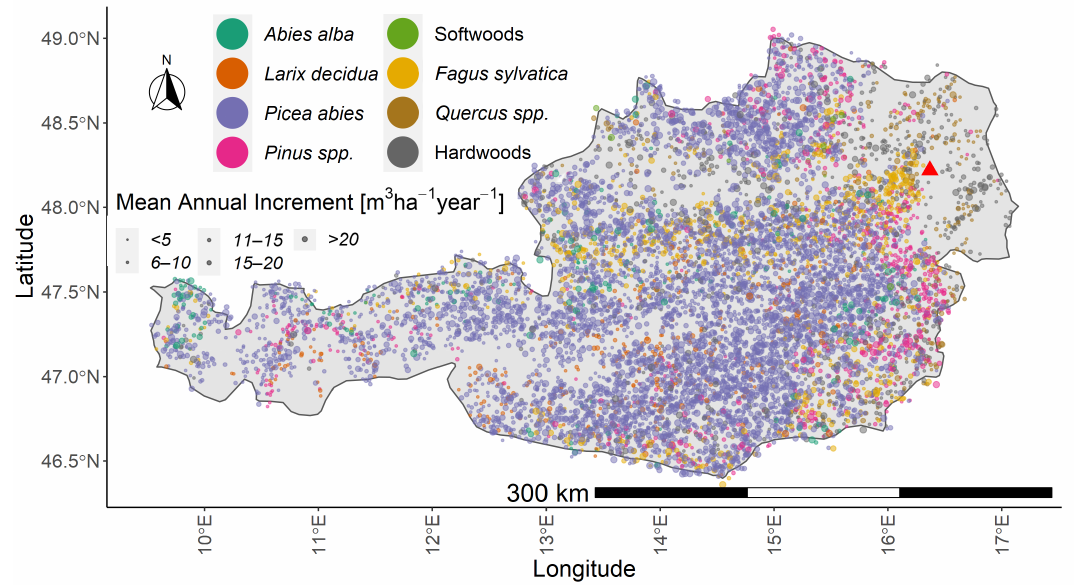
Figure 2. Dominant species in Austria. Jittering was applied to the points to reduce overlapping. Other hardwood species and softwood species were pooled into “hardwoods” and “softwoods”. The sizes of the circles show the approximate mean annual increment per plot. Data are from the Austrian National Forest Inventory (2009). The red triangle indicates Vienna.